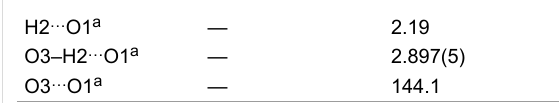
Table 1: Selected distances (Å) and angles (°) of compounds 8 and 10 ·CH 3 OH.